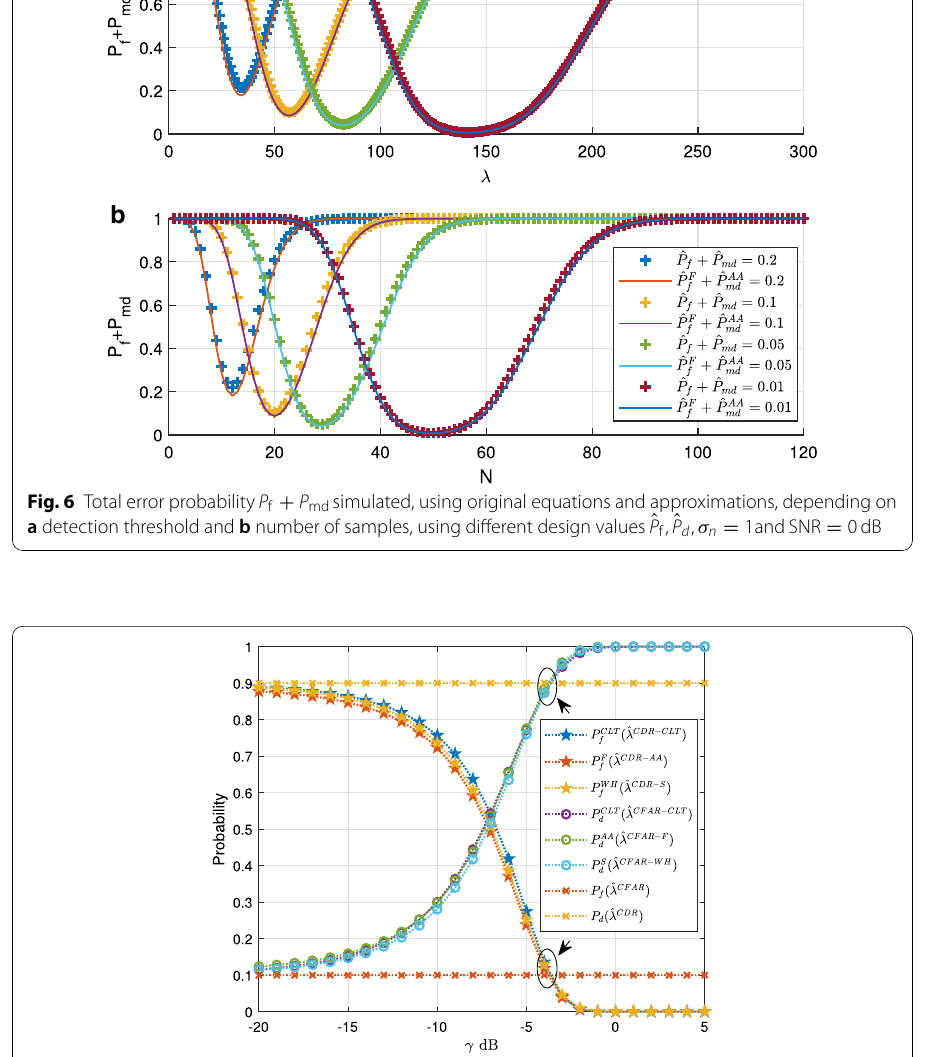
50 . The arrows show =